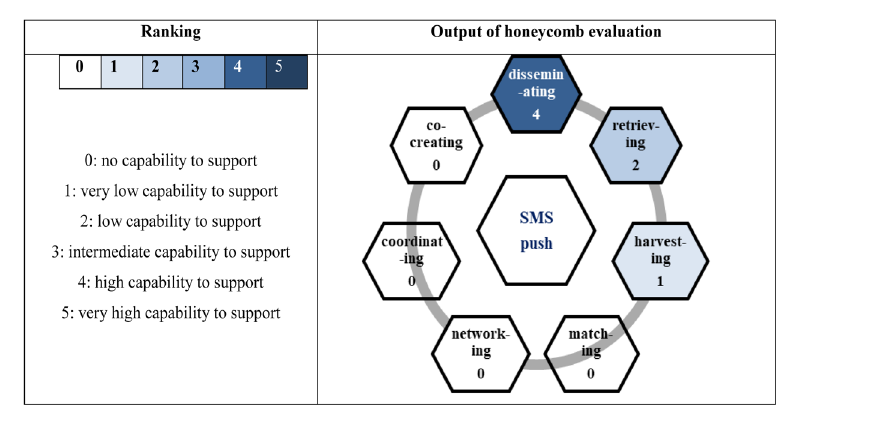
Figure 2: Example of honeycomb evaluation output (for “SMS push